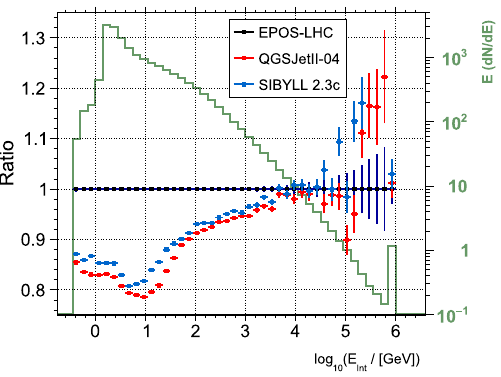
Fig. 8 On the left y-axis, the ratio between the hadronic interaction distributions in PeV proton showers is shown for each high energy model with respect to EPOS-LHC. Labelled in green and on the right y-axis, EPOS-LHC’s hadronic interactions distribution is shown for a PeV proton initiated